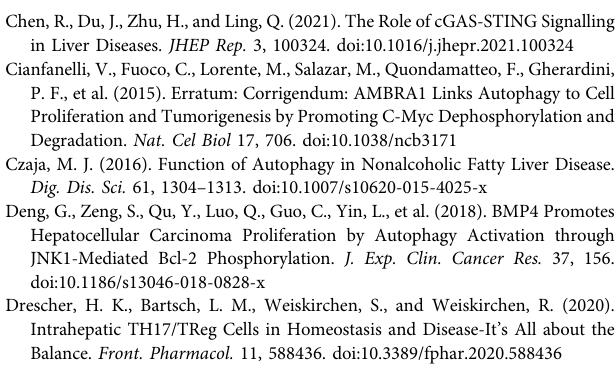
autophagic functions ( Figure 4 ).